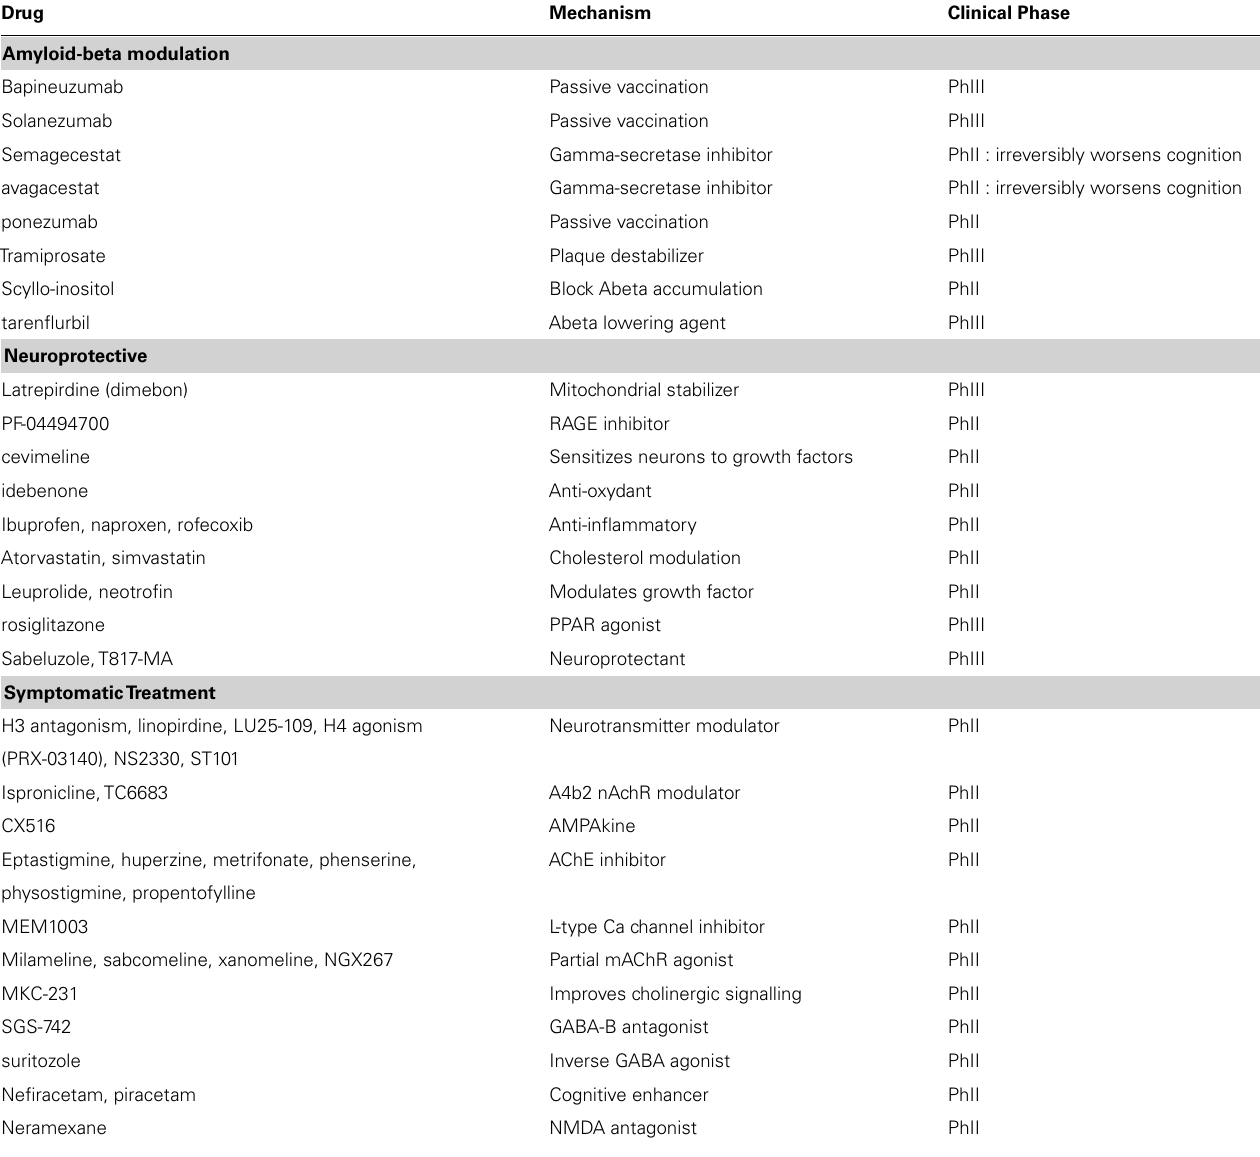
Table 1 | List of failed therapeutic interventions inAlzheimer’s disease over the last 10 years, ordered according to the general mechanism. Many drugs failed in Phase II proof-of-concept, some failed in Phase III pivotal trials.